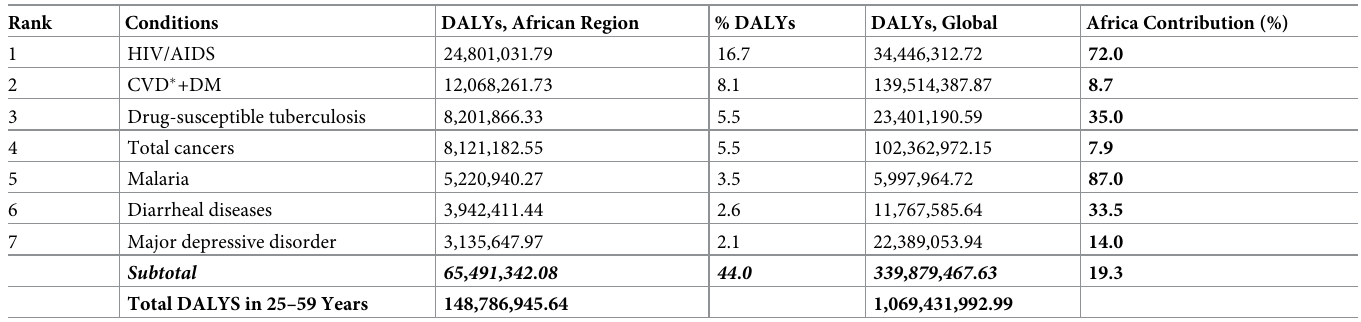
� CVD combines the following conditions: ischemic heart disease, intracerebral haemorrhage, ischemic stroke, hypertensive heart disease, rheumatic heart diseases, congenital heart diseases and peripheral artery disease. Cardiovascular diseases and diabetes mellitus are considered together as the interventions that address the risk factors are